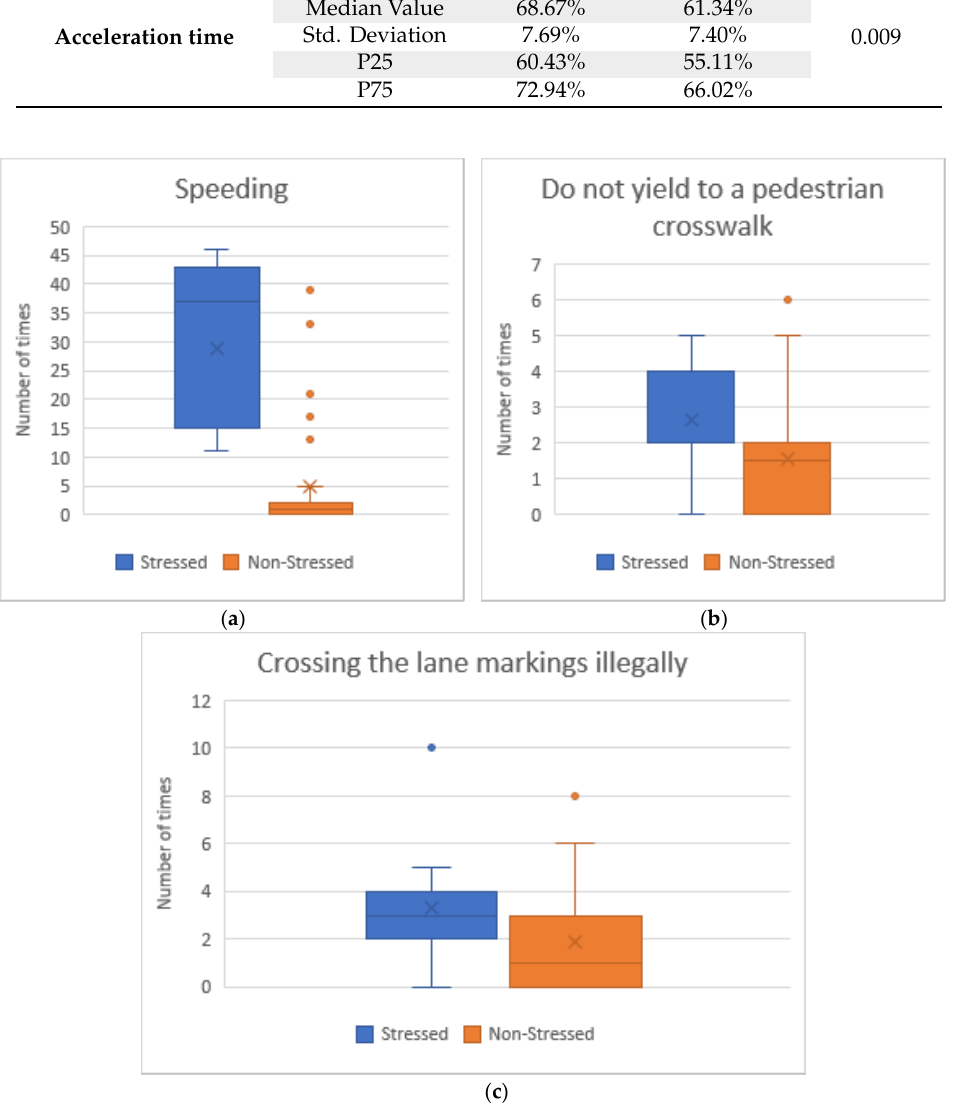
Figure 2. Average number of tra ffi c rules broken grouped by initial stress level: ( a ) Speeding; ( b ) Do not yield to a pedestrian at a crosswalk; and ( c ) Crossing the lane markings